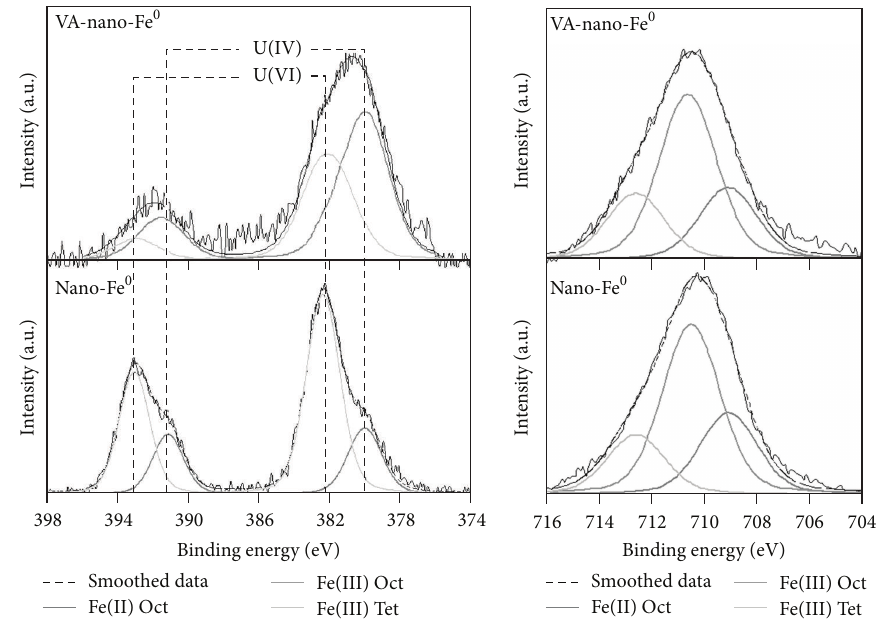
Figure 8: Curve fitted XPS U 4f (left) and Fe 2p 3/2 (right) photoelectron peaks acquired after 24 hours reaction time for mine water solutions treated with as-formed and vacuum annealed nano-Fe 0